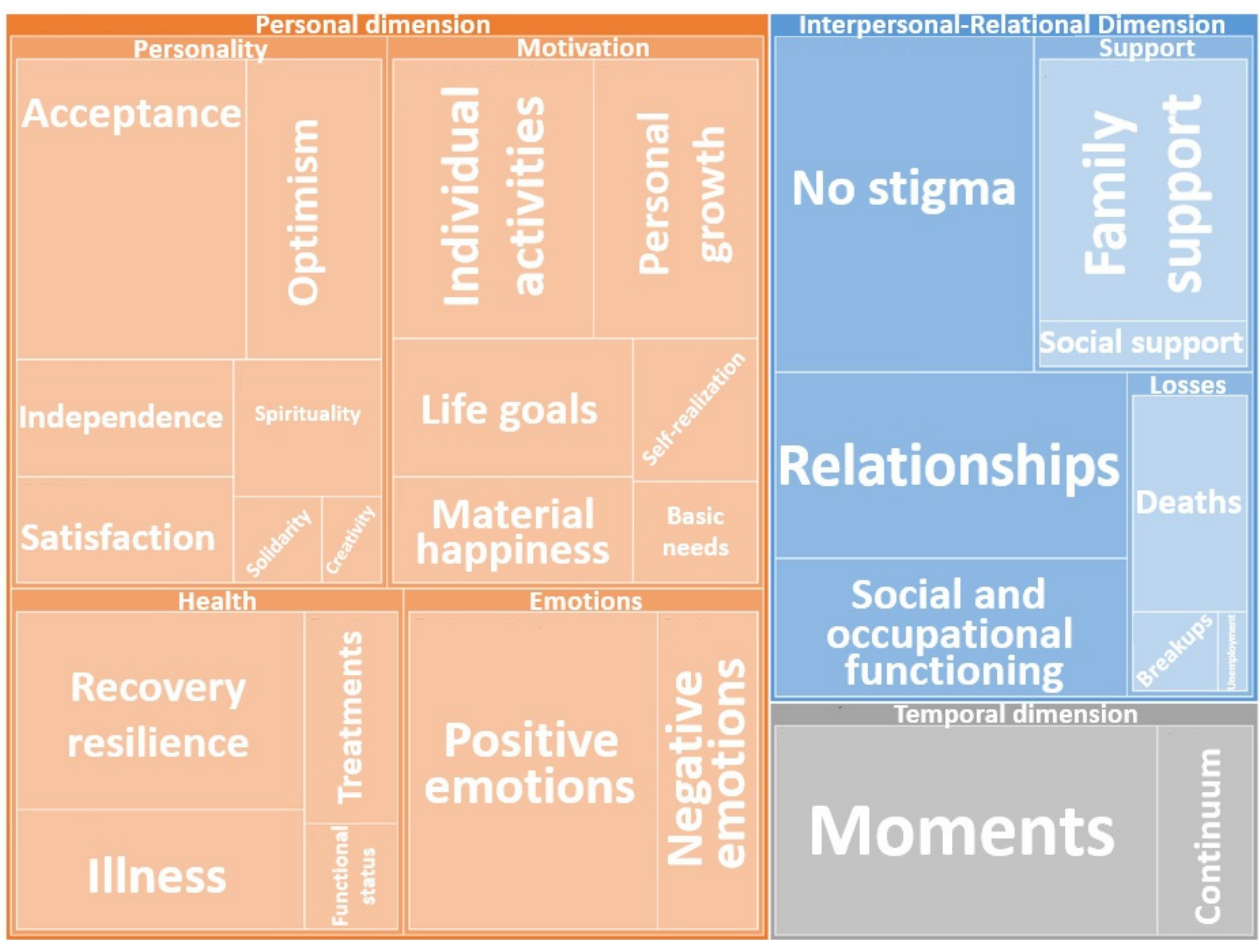
Figure 2. Concept: hierarchical map.